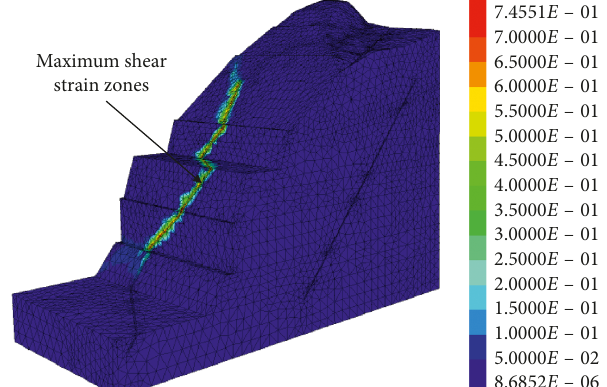
Figure 5: Contour plot of the maximum shear strain after exca- vation of the slope (Case